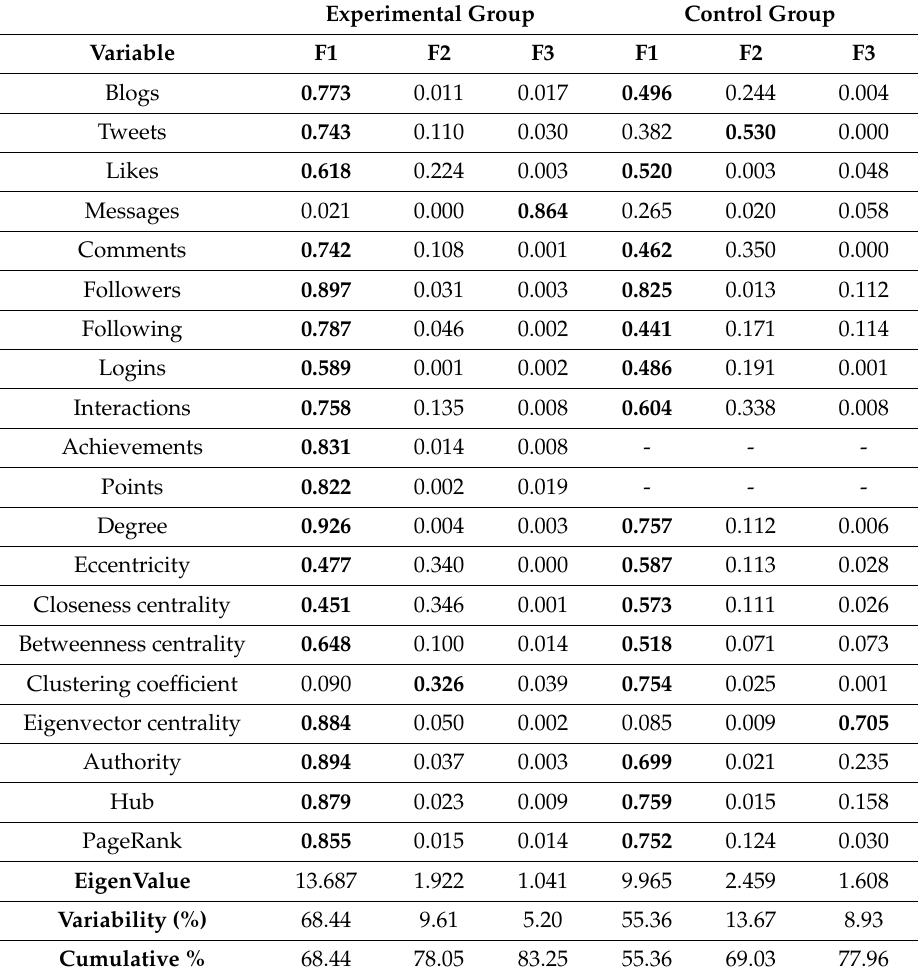
Table 3. Results of the PCA: squared cosines of the variables, eigenvalues, and variability of the factors. Values in bold correspond to the factor for which the squared cosine is the largest. Experimental